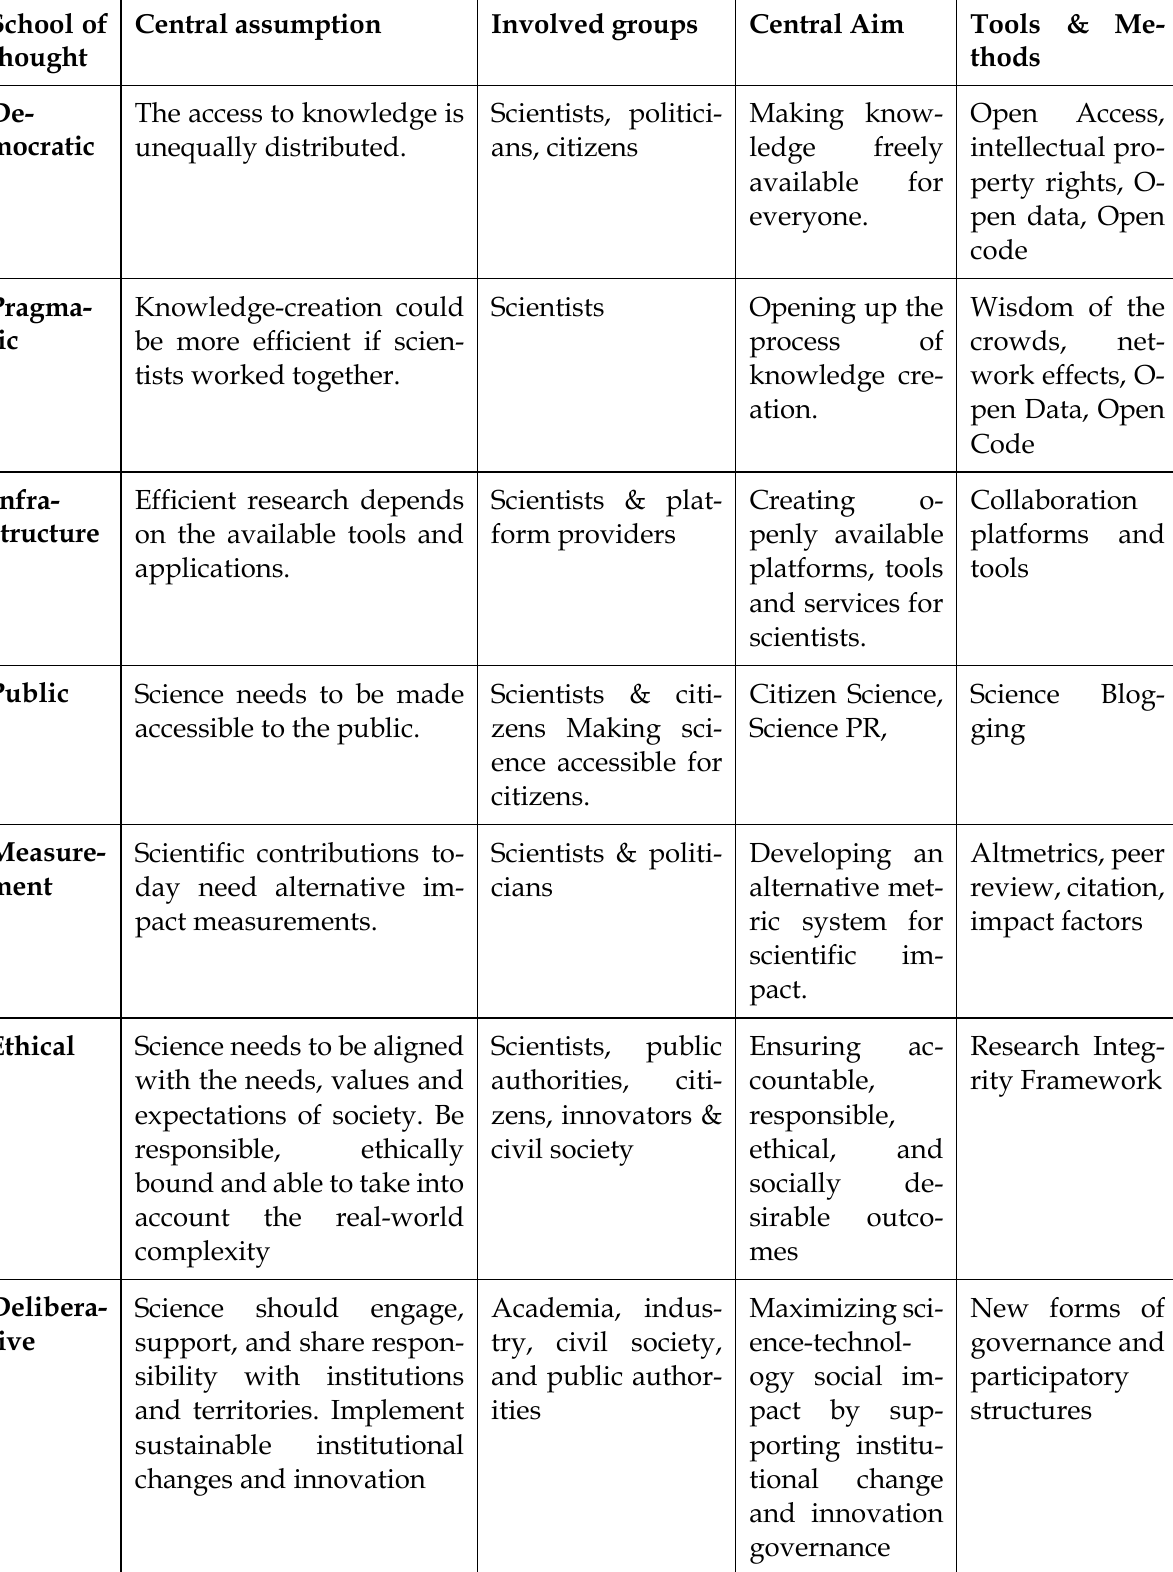
Table 1 Open Science schools of thought. Source: Authors’ elaboration on (Fecher and Friesike